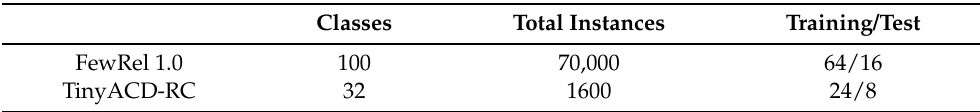
Table 2. Detailed structures of the used datasets, where Classes is total relation types in a dataset, and Training/Test is the ratio of Training/Test